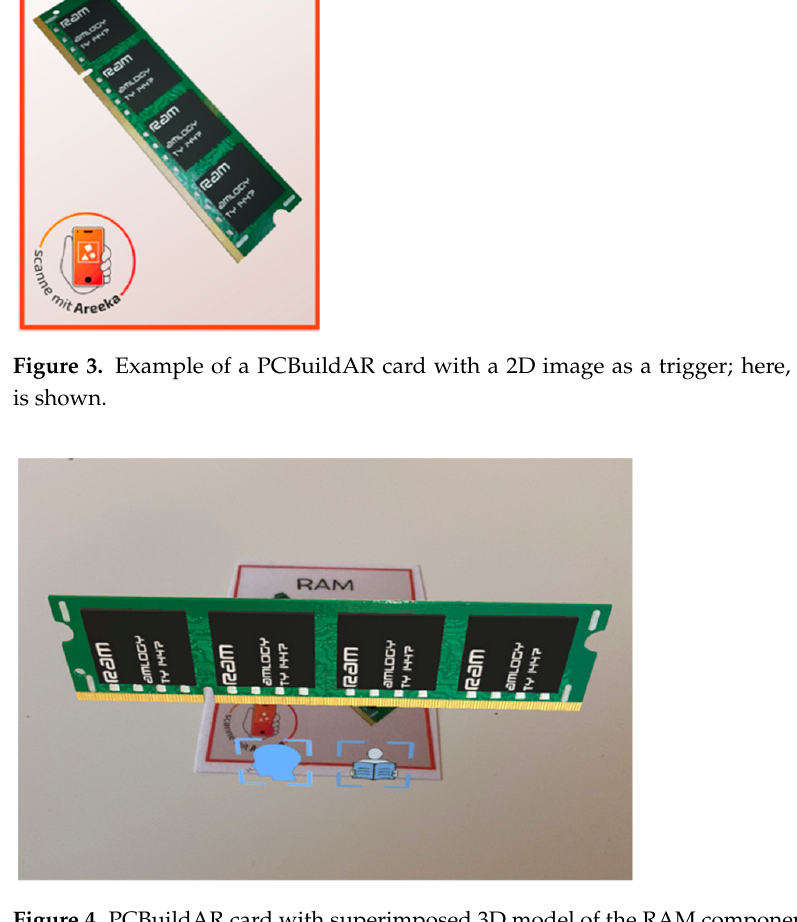
Figure 4. PCBuildAR card with superimposed 3D model of the RAM component.